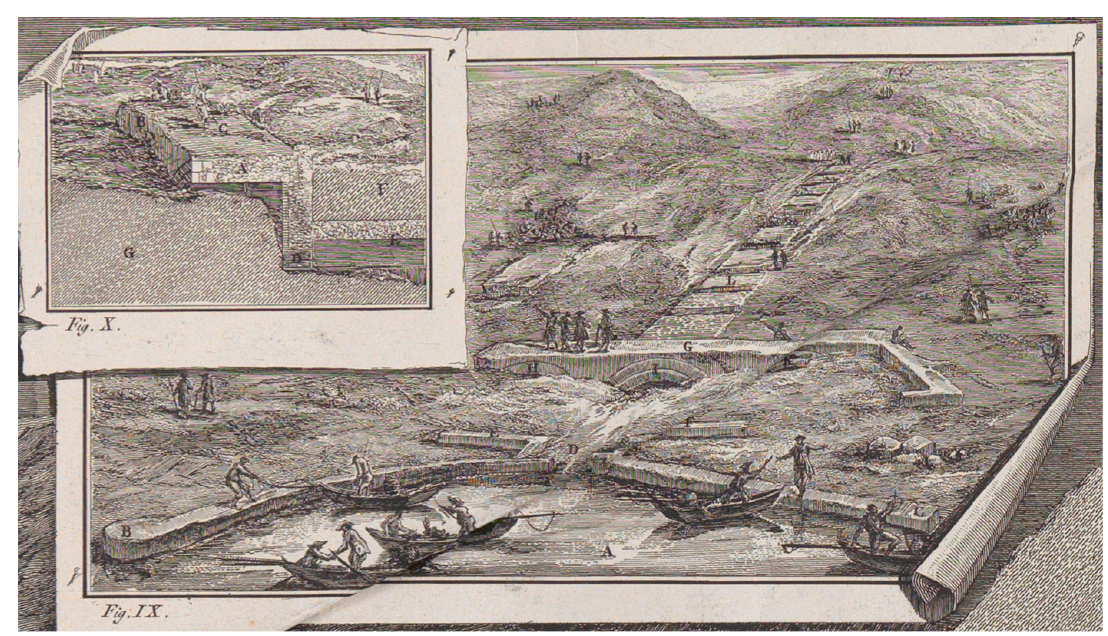
Figure 5. Representation of the Roman incile executed by F. Piranesi in 1790.